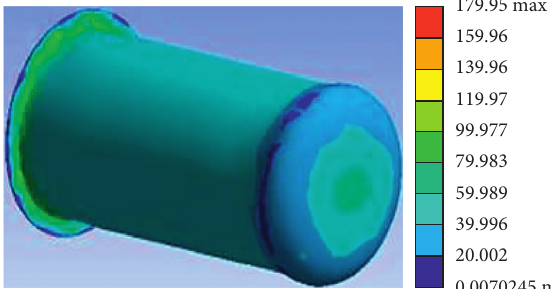
Figure 23: Equivalent stress cloud diagram of the uncoupled flame